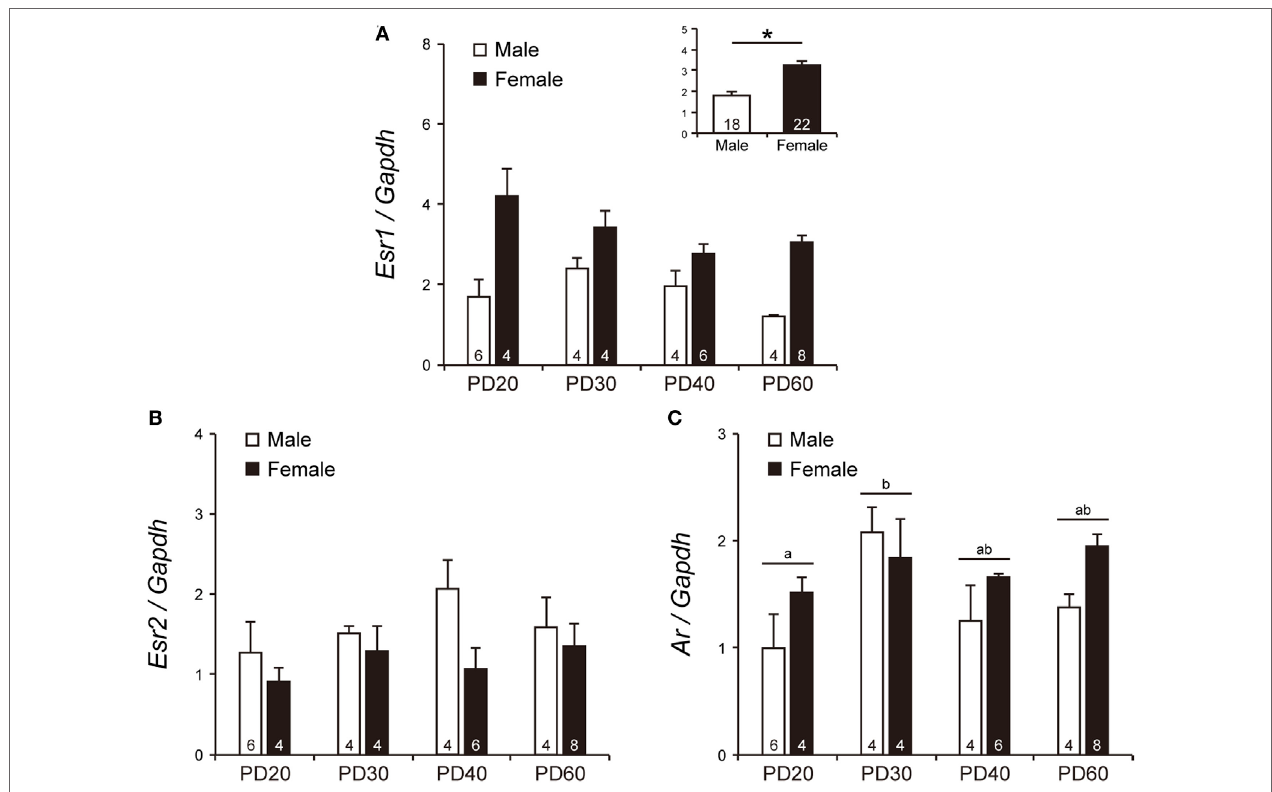
FigUre 3 | The mRNA levels of Esr1 , Esr2 , and Ar in the AVPV of peripubertal mice. The mRNA levels of Esr1 (a) , Esr2 (B) , and Ar (c) in male and female mice on PD20, PD30, PD40, and PD60. The inset graph in panel (a) indicates the average mRNA level of Esr1 in all ages. The numbers in the columns indicate the numbers of animals. Values are the mean ± SEM. Differences in values that are significantly ( p < 0.05) different from each other are indicated with letters. * p <